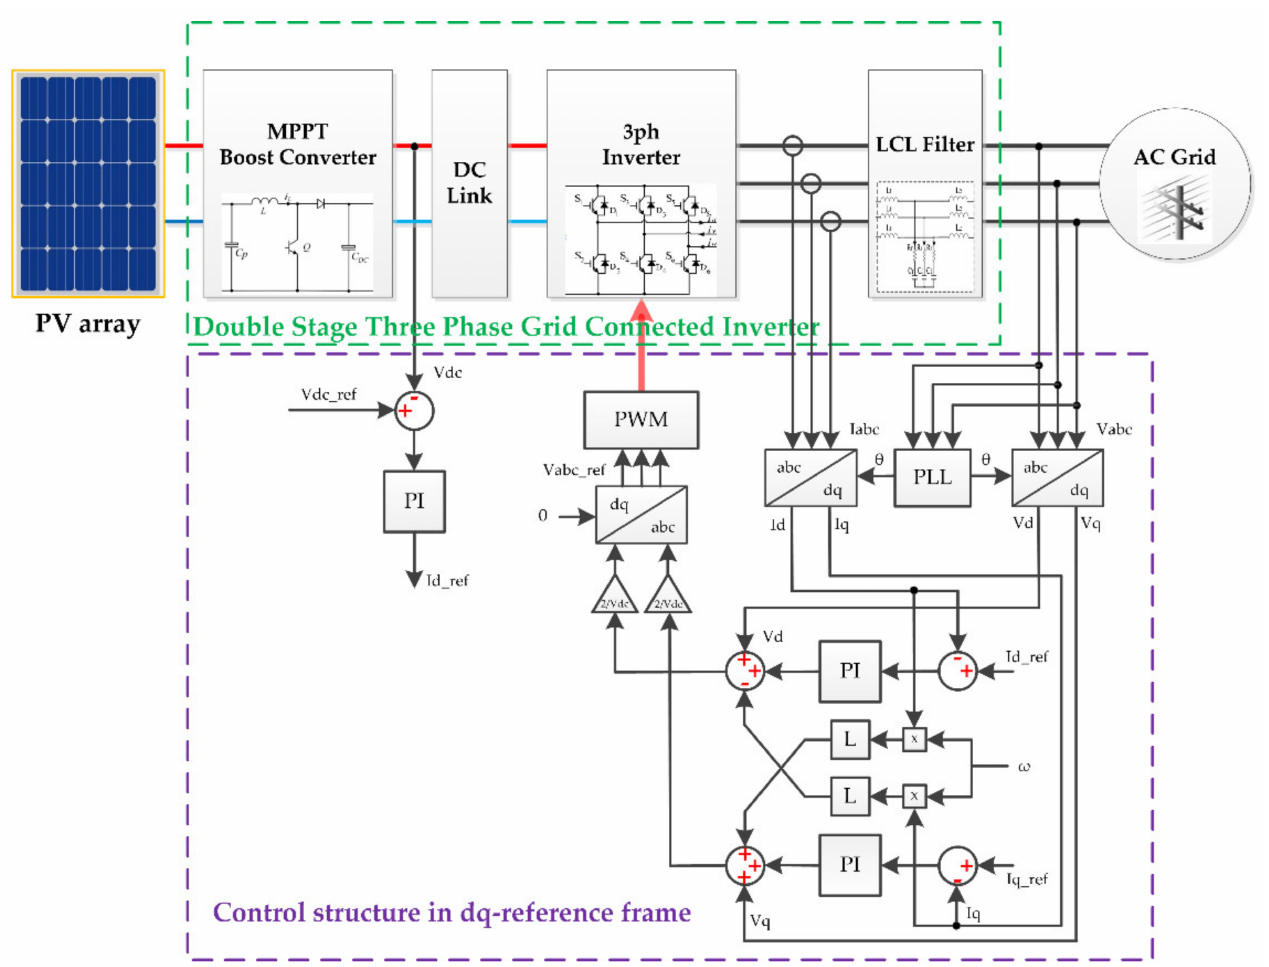
Figure 3. Block structure of grid-connected PV system model with double-stage three-phase